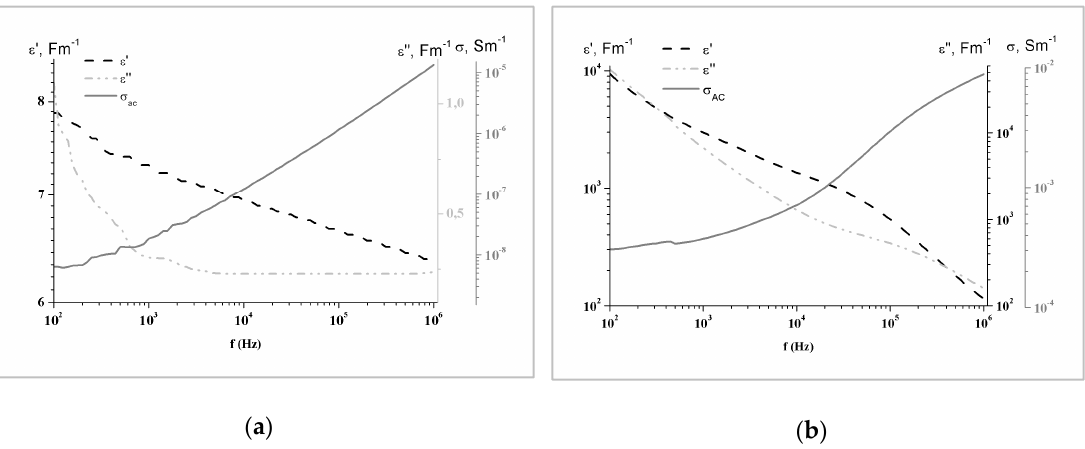
Figure 5. Real and imaginary parts of the complex permittivity, ε *(f) = ε ’(f) – i ε ”(f) , and the calculated electrical conductivity, σ AC , as function of frequency at T = 350 K for LignoBoost ® kraft lignin-based copolymer ( a ) undoped and ( b ) doped with 1.4% (w/w) MWCNTs.